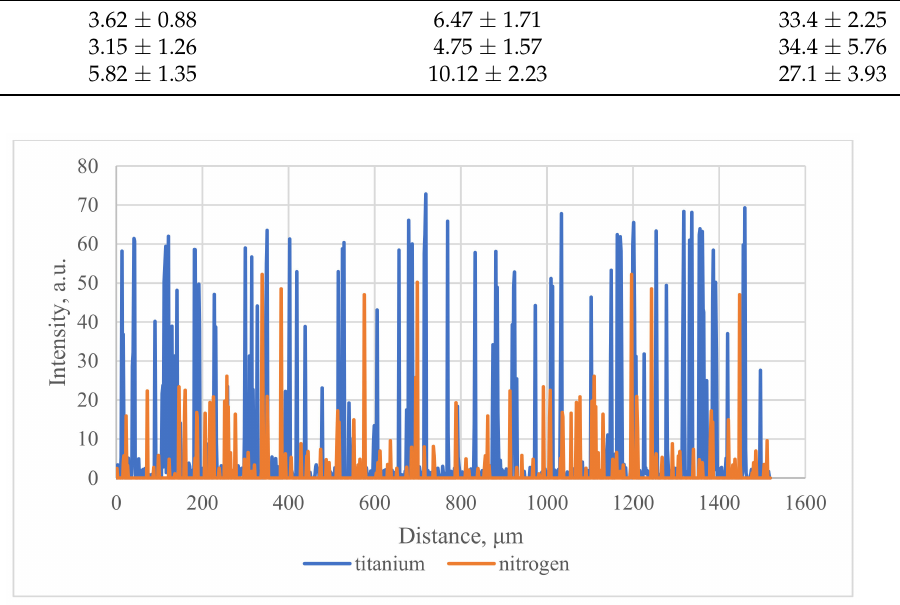
Figure 4. The titanium and nitrogen profile on the cross-section of a representative homogeneous laser-alloyed surface layer, from SEM/EDS line-scan analysis. Profile was taken in the center of the bead from surface to fusion